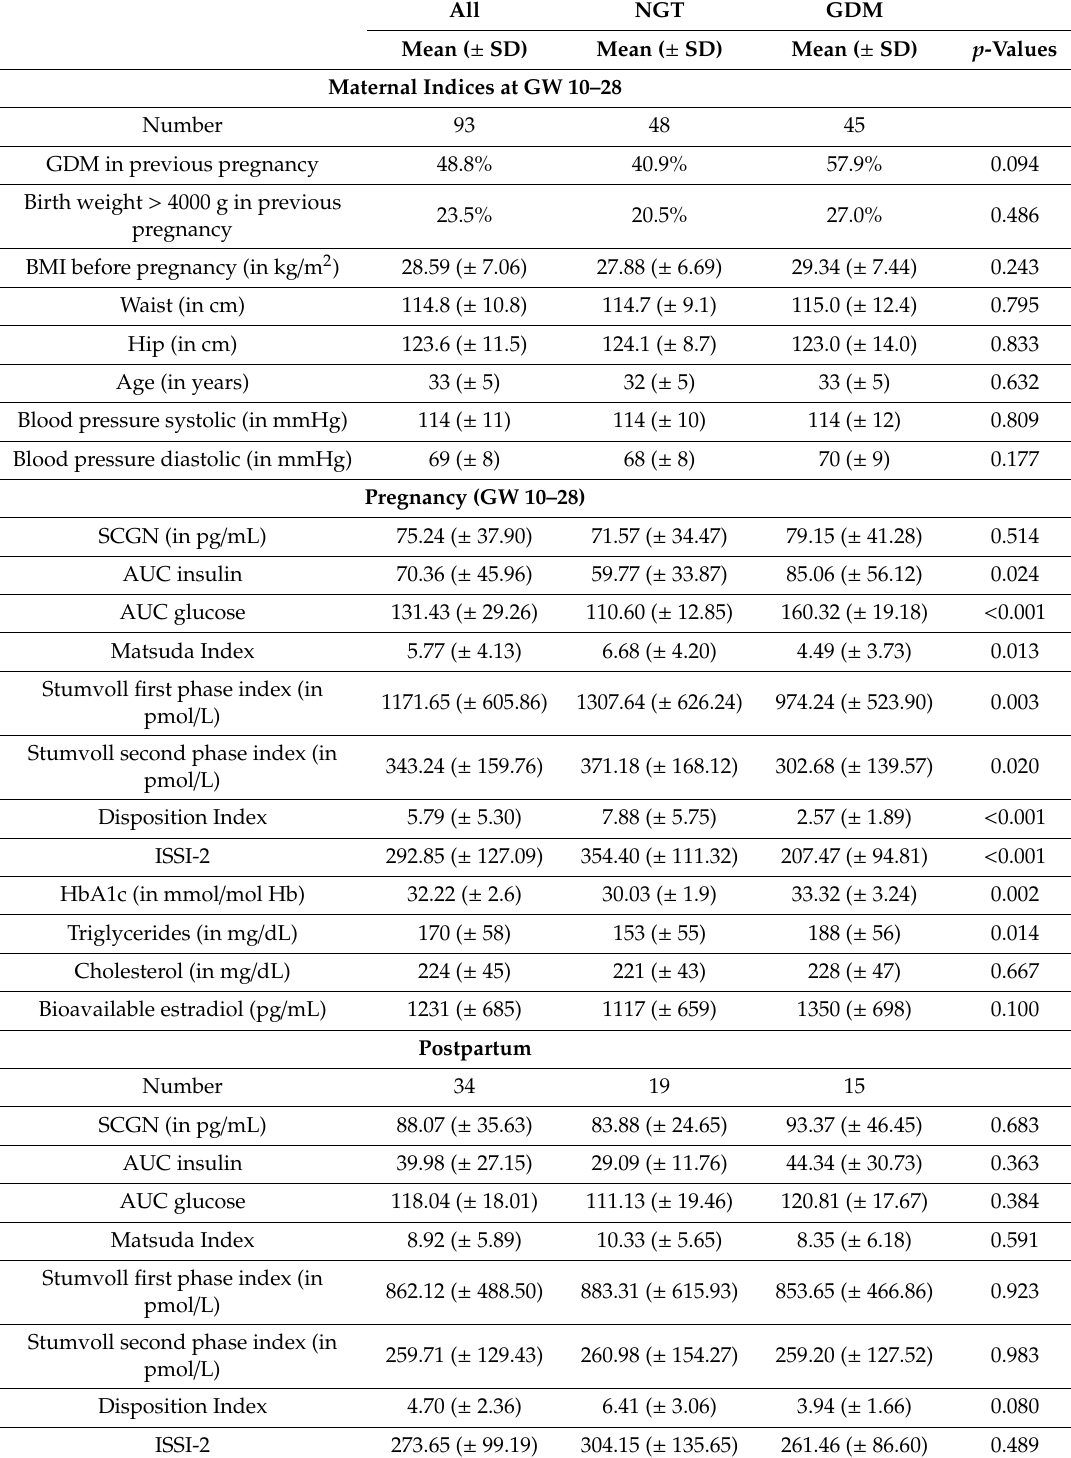
Table 1. Baseline characteristics and glycemic and metabolic parameters of oral glucose tolerance tests (OGTT) at GW 10–28 and postpartum for NGT and